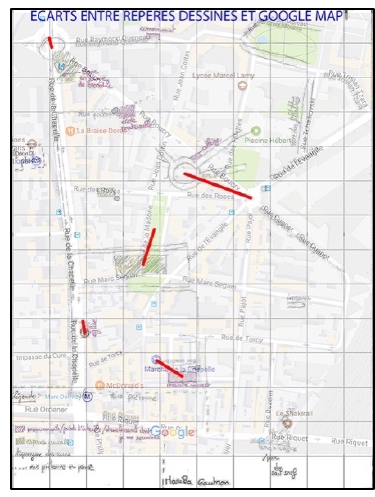
Figure 12. Example of superposition of each sketch map with Google map at the same scale and Measurement of distances between landmarks in Google map and landmarks in sketch map